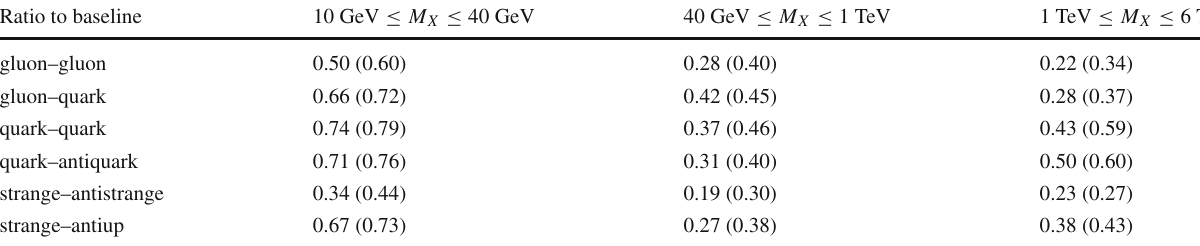
Table 3 The reduction of the PDF uncertainties compared to the PDF4LHC15 baseline for different initial partonic combinations (that is, a value of 1 corresponds to no reduction at all). Results are presented forthreedifferentbinsoftheinvariantmass M X oftheproducedsystem,